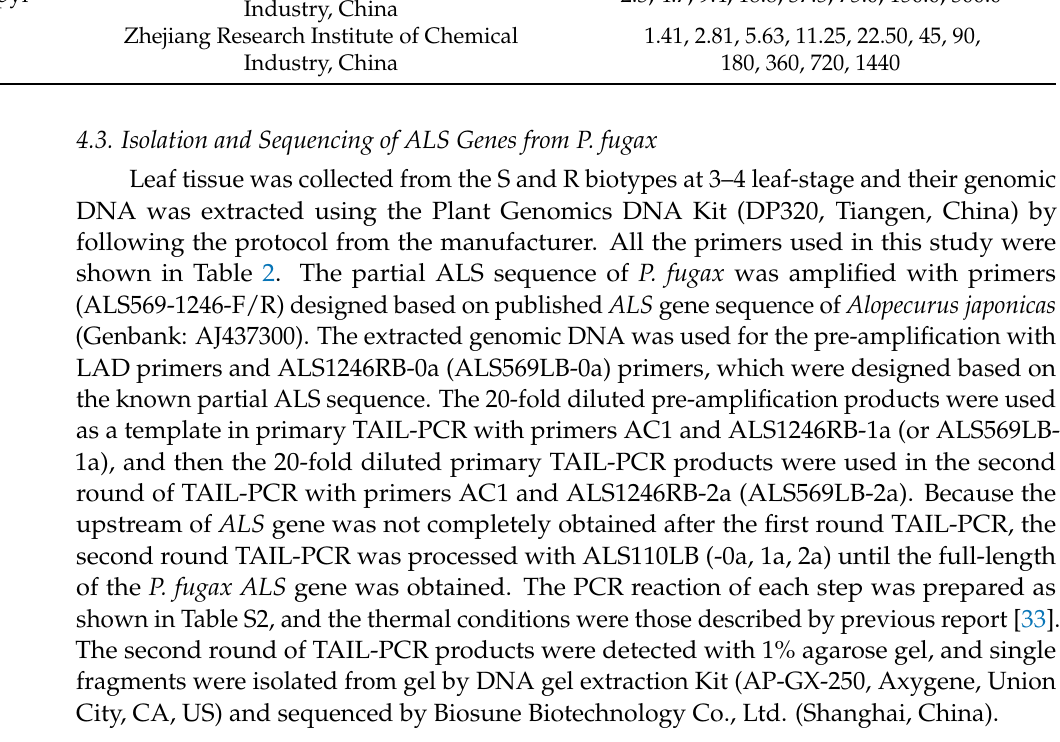
Table 2. The primers used in this